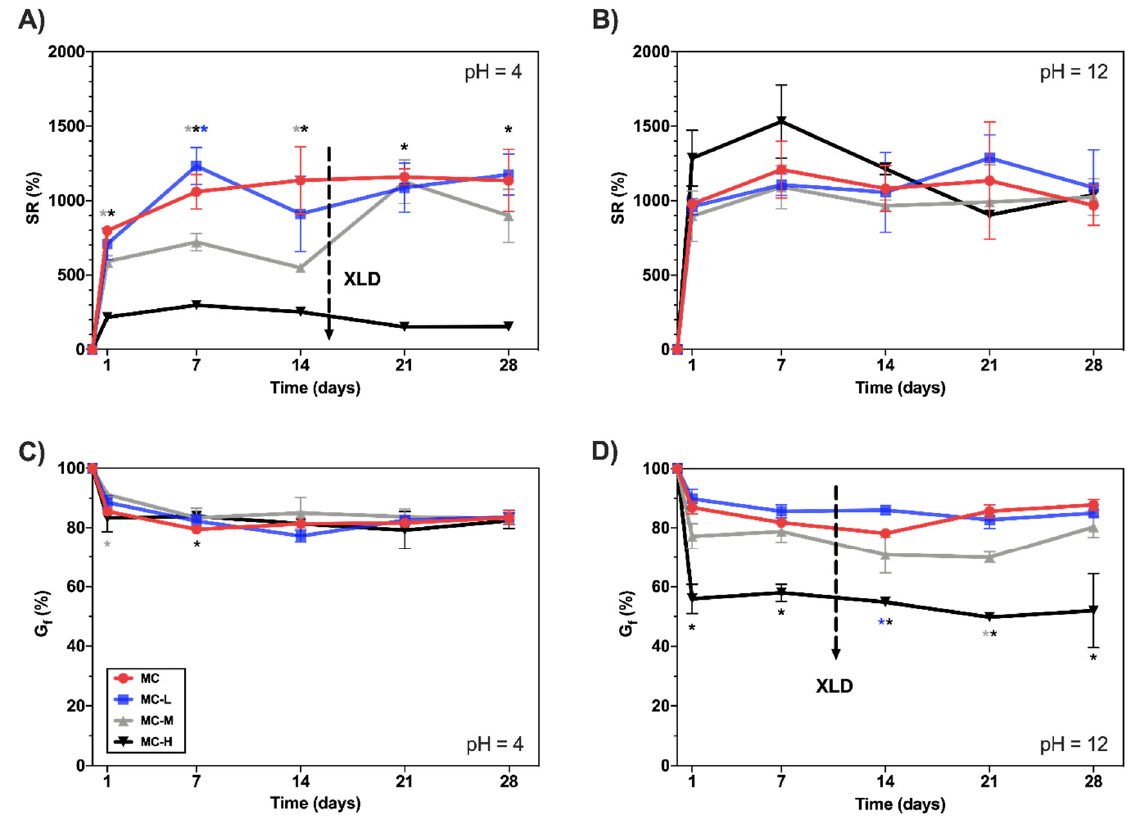
Figure 1. SR (%) vs. time of MC hydrogels in NSS at T = 37 °C. ( A ) pH = 4; ( B ) pH = 12. G f (%) vs. time curves of MC hydrogels samples in NSS at T = 37 °C. ( C ) pH = 4; ( D ) pH = 12. * = p < 0.05 compared to MC control (* = MC vs. MC-L, * = MC vs. MC-M, * = MC vs. MC-H).